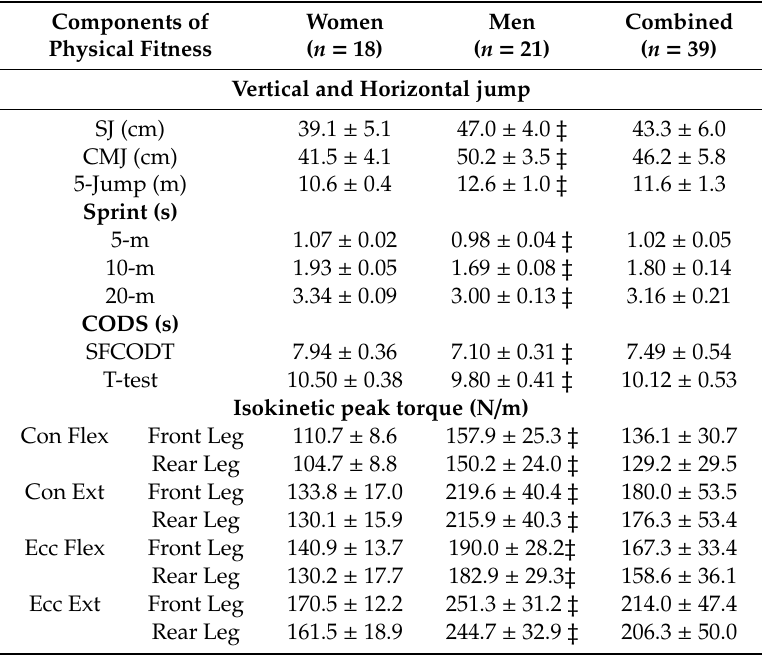
Table 2. Physical characteristics of fencers *.